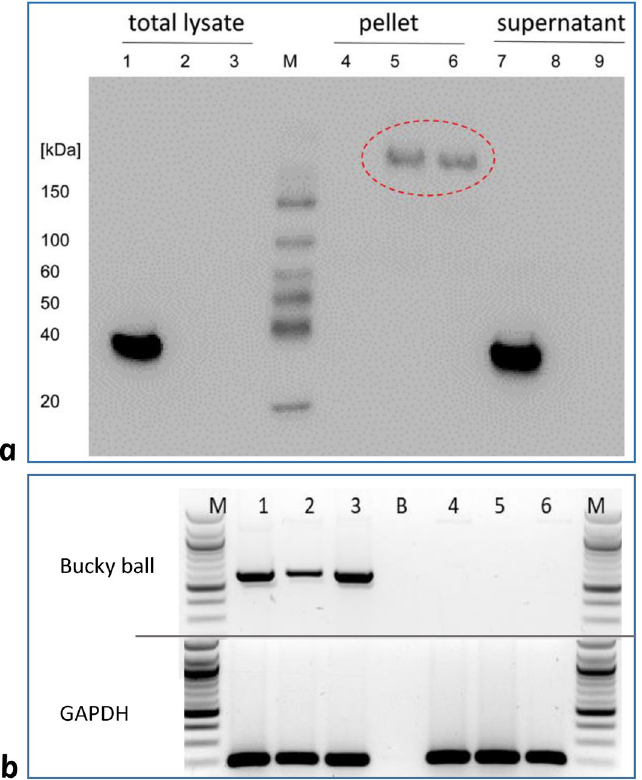
Figure 3. Expression of Bucky ball after transfection of fusion plasmids in vitro and in embryonic stages around oviposition in vivo (a) Bucky ball fusion-constructs form insoluble fusion proteins. Bucky ball fusion construct and controls (EGFP/Venus only) were transfected in DF1 cells, respectively. After 5 days, the cells were harvested, and total extracts, insoluble, and soluble fractions were assessed by Western blotting with an anti-GFP antibody. Controls (EGFP/Venus only, lanes 1, 4, and 7), zebrafish Bucky ball-EGFP (lanes 2, 5, and 8), and chicken Bucky ball-Venus fusion constructs. M, size marker with visible bands at 20, 40, 50, 60, 100, 150 kDalton. Note, the Bucky ball fusion proteins appear in the insoluble fraction (lanes 4, and 5) and migrate much slower than expected for the calculated molecular weights of 101 kDa (zBucky ball-EGFP) and 116 kDa (cBucky ball-Venus). The EGFP/Venus control shows a protein at the expected molecular weight of 27 kDa. ( b) Detection of embryonically transcribed Bucky ball in the chicken blastoderm. The upper panel refers to Bucky ball and the lower panel to GAPDH transcripts. Samples 1 to 3 were generated from stage EGK X 28 laid egg blastoderms, and samples 4 to 6 from 24 h incubated embryos (stage HH 6 27 ). DNA-ladder in lanes (M): NEB 100 bp ladder N3231, (B) negative control amplification without